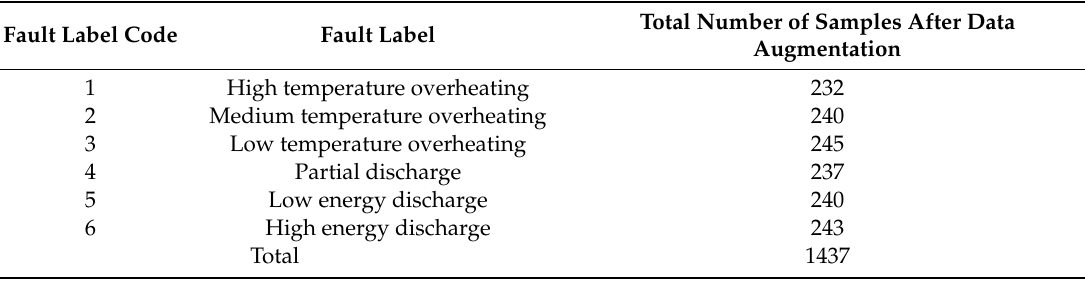
Table 3. Distribution of the new data set.